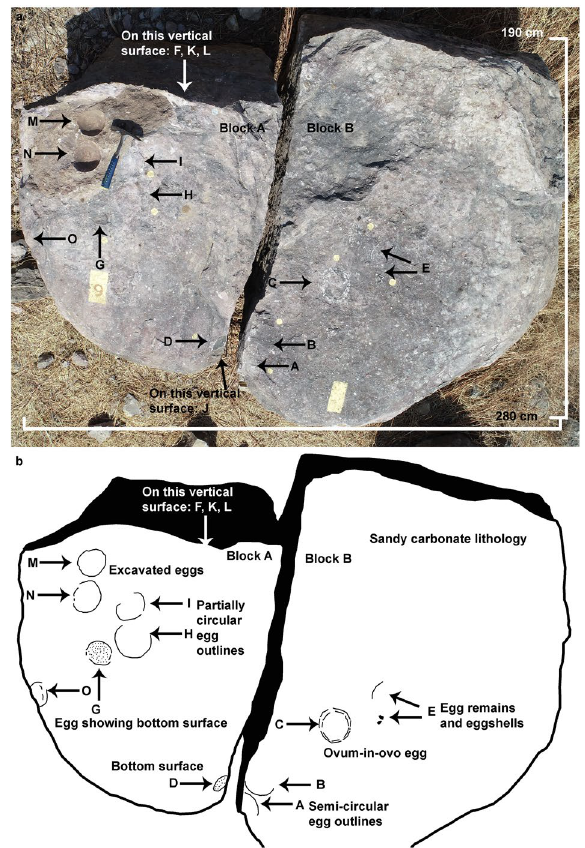
Figure 4. Field photograph and schematic diagram of the outcrop showing nest P7 and its eggs and eggshell fragments belonging to a titanosaur sauropod randomly spaced with respect to each other in a circular nest arrangement. The captions A to O indicate eggs and eggshell locations (Fig. 4b drawn using software Adobe Photoshop CC).